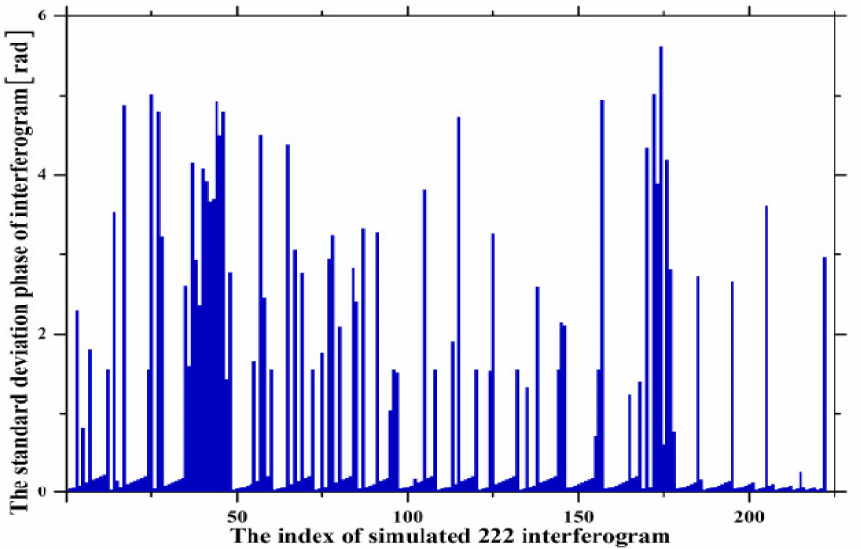
Figure 4. Standard deviations of 222 simulated